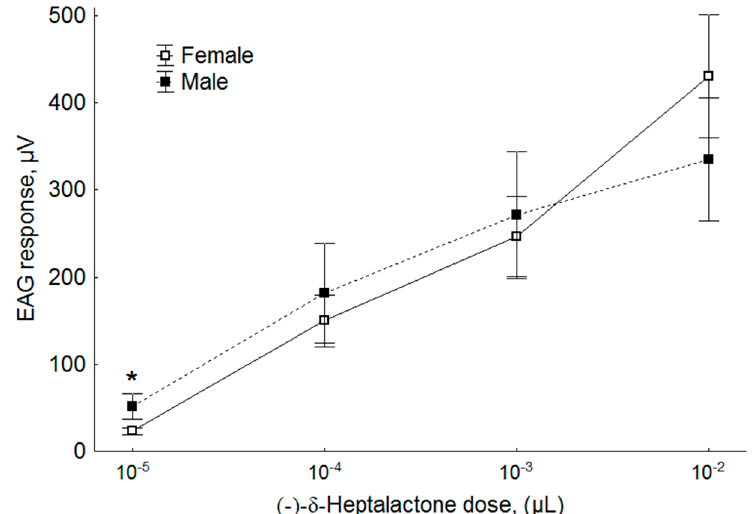
Figure 6. Electroantennogram (EAG) responses (mean amplitude ± standard error (SE), mV) of male and female R. batava to different doses (1 × 10 − 5 to 1× 10 − 2 µL) of synthetic (-)- δ -heptalactone. The asterisk denotes significant differences in EAG responses between sexes (Mann–Whitney U Test, Z = − 2.08 p = 0.037); each EAD test was replicated five times and each antenna used was from a di ff erent